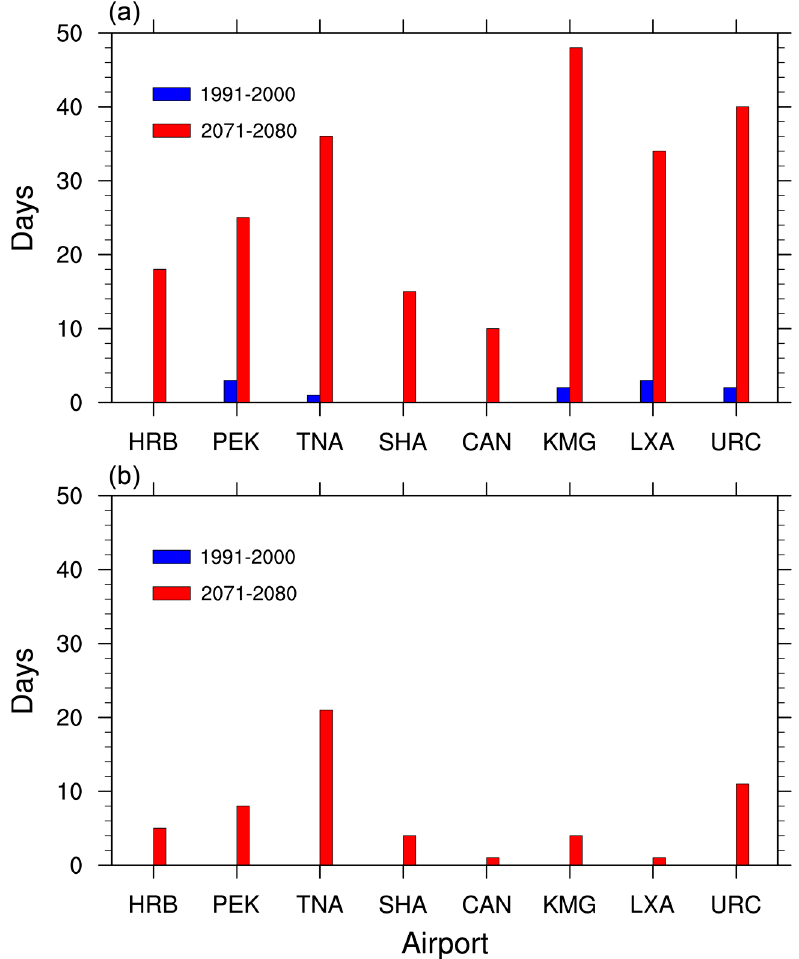
Figure 5. Number of two levels of weight weight-restriction days per year during 1991 − 2000 (blue bar) and 2071 − 2080 (red bar): ( a ) 1000 lb restriction; ( b ) 5000 lb restriction.